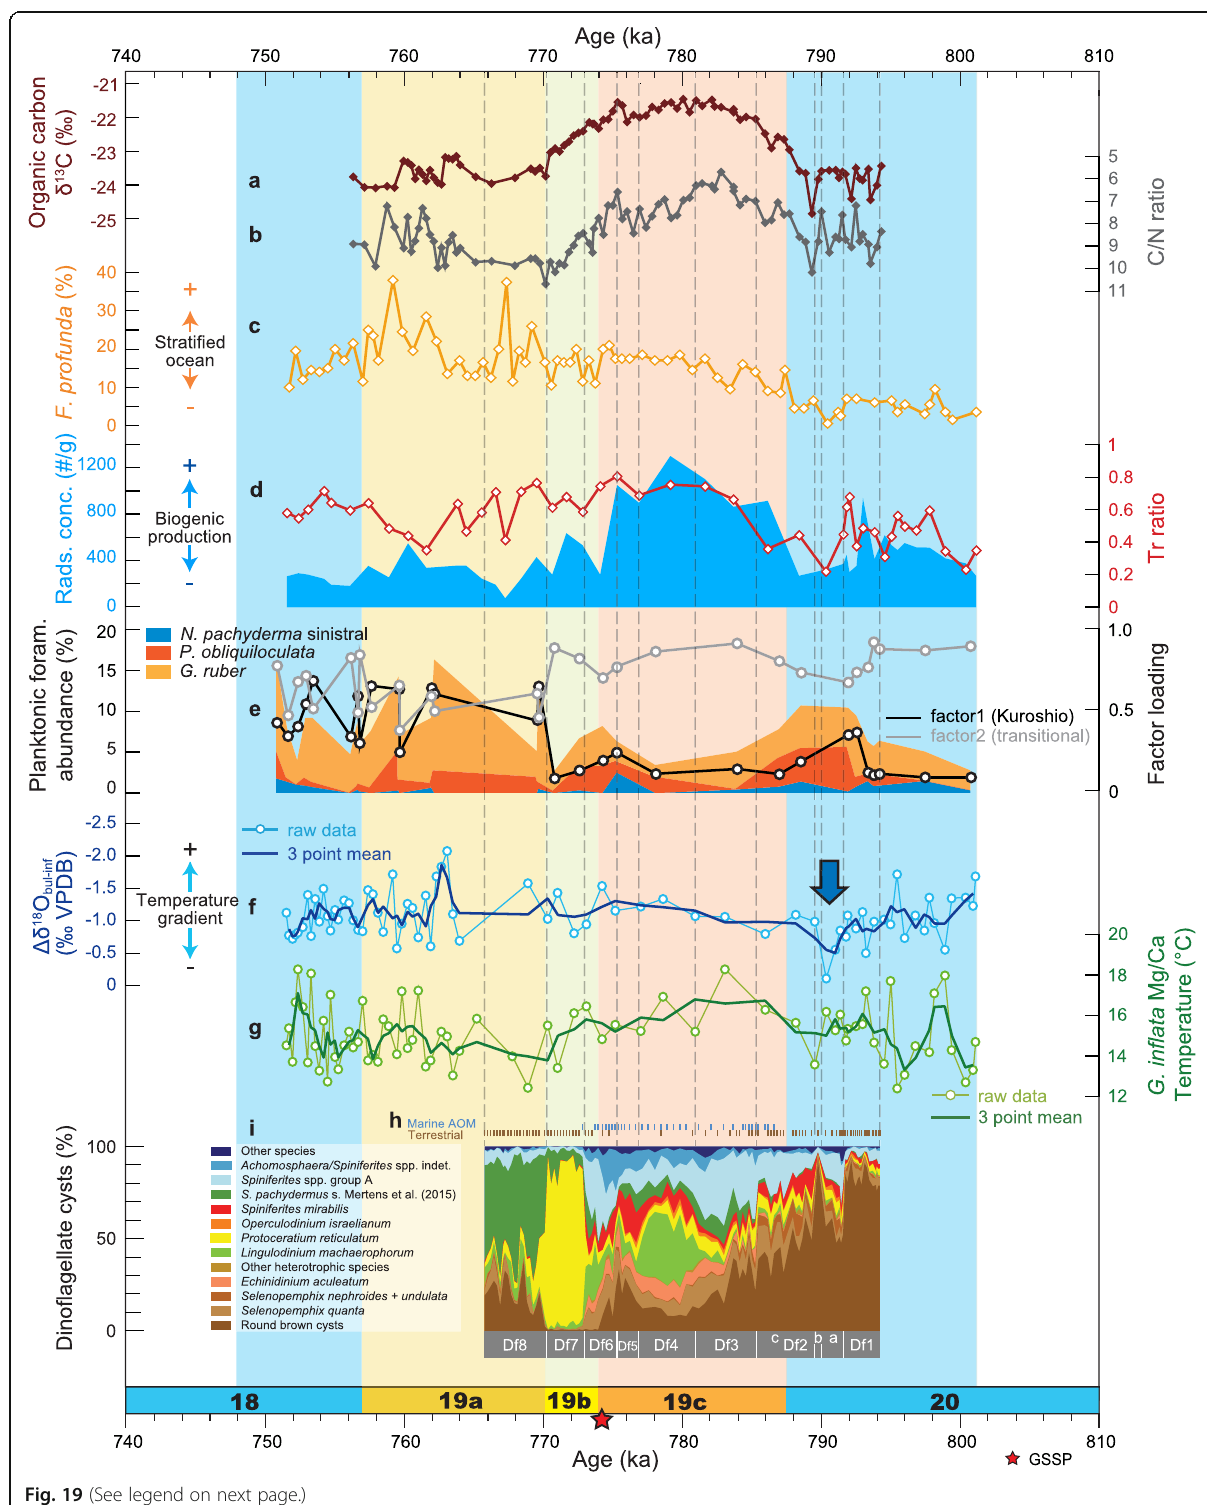
Fig. 19 (See legend on next